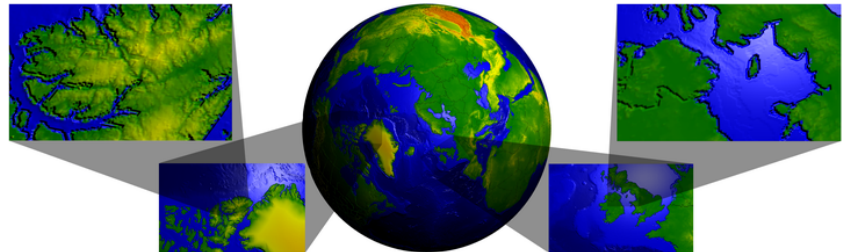
Figure 1. A multilevel Digital Earth visualization. Created by Sherlock et al., from [7]. Digital Earth